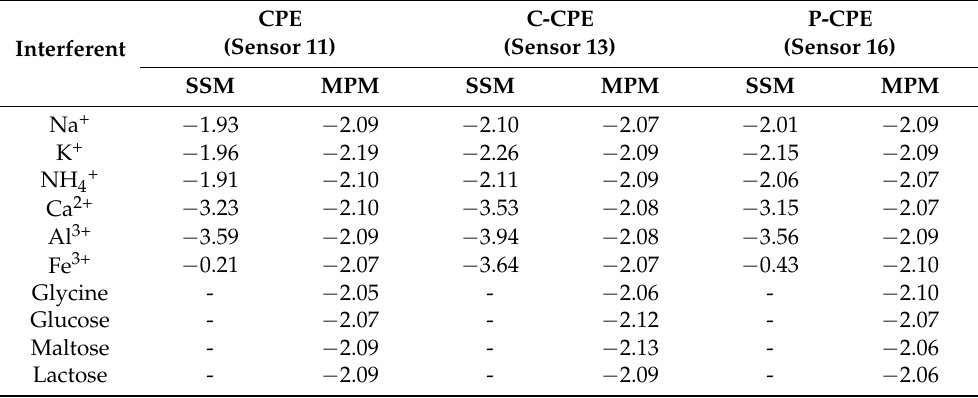
Table 4. Selectivity coefficient log, log K pot. of 22 ± 2 ◦